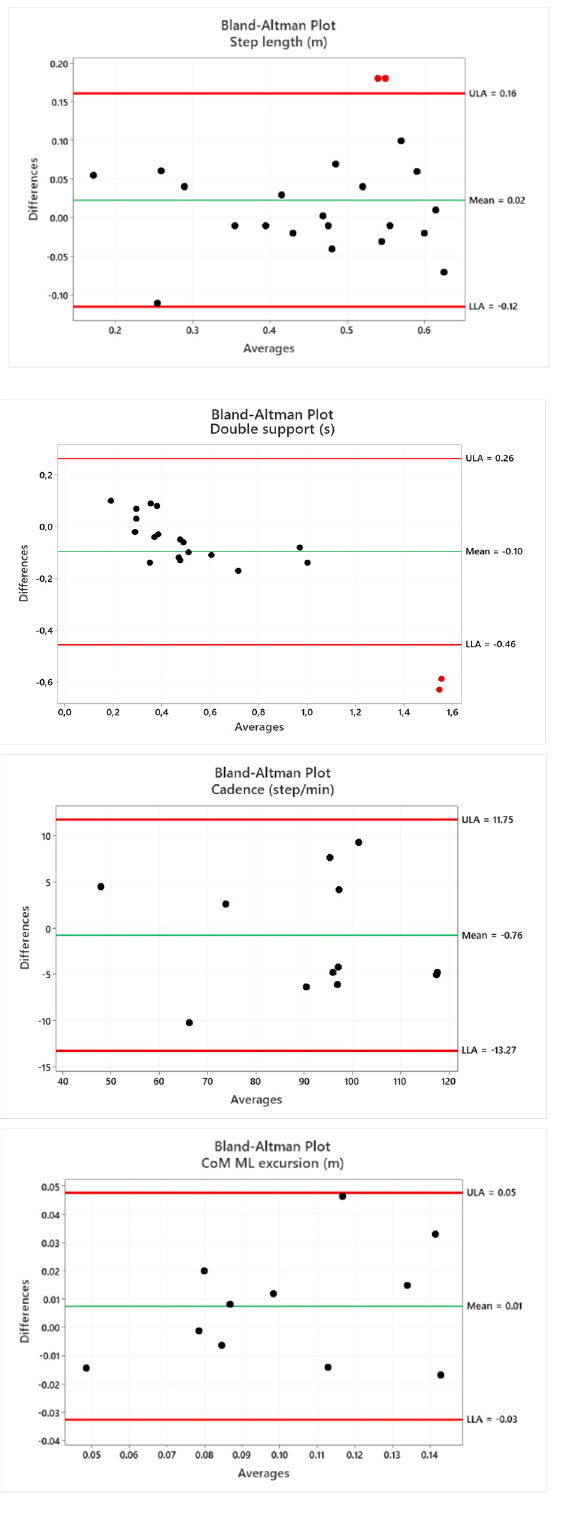
Figure 6. Bland–Altman plots of the mean of instrumented 3D-GA and the RGB-D systems plotted against the difference between the two methods. For all spatiotemporal parameters, 22 values are reported because they are considered separately for the right and left limb, with the exception of cadence [12] and parameters related to COM.